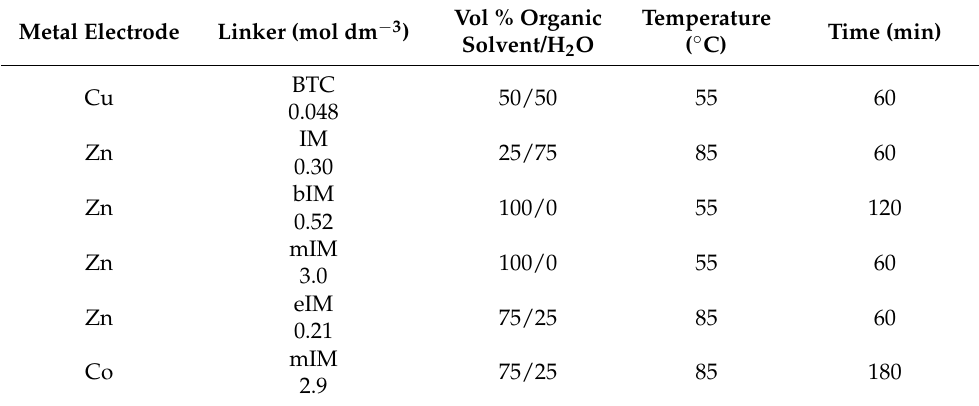
Table 2. Summary of the conditions used to produce a range of MOF coatings using